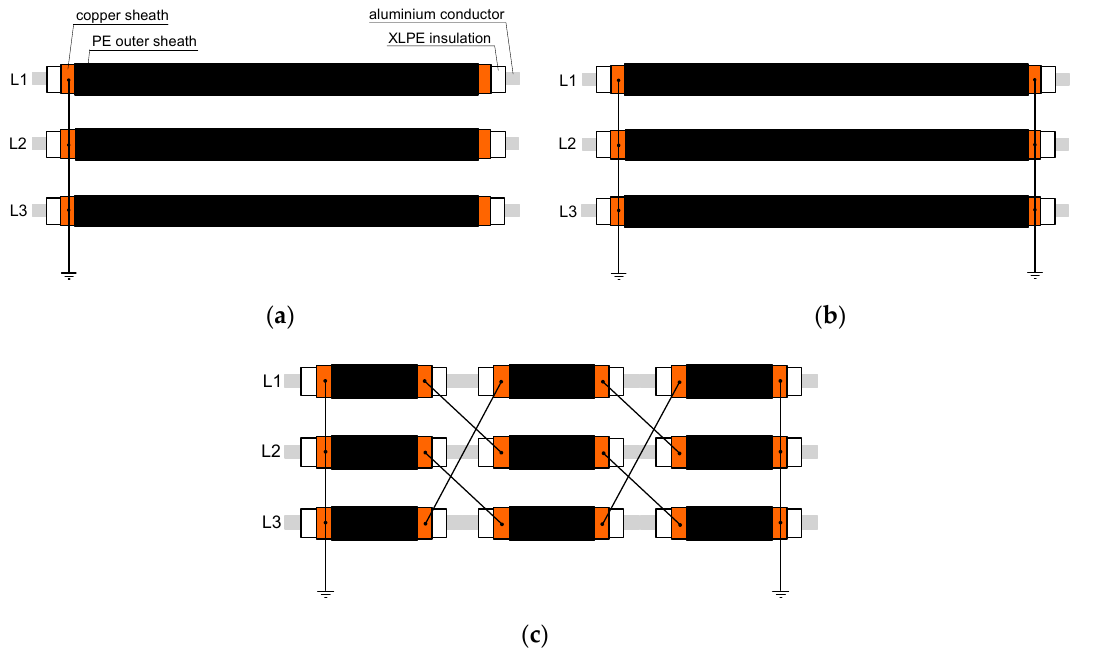
Figure 1. High-voltage power cables arrangements: ( a ) single-point bonding; ( b ) both-ends bonding; ( c ) cross bonding.